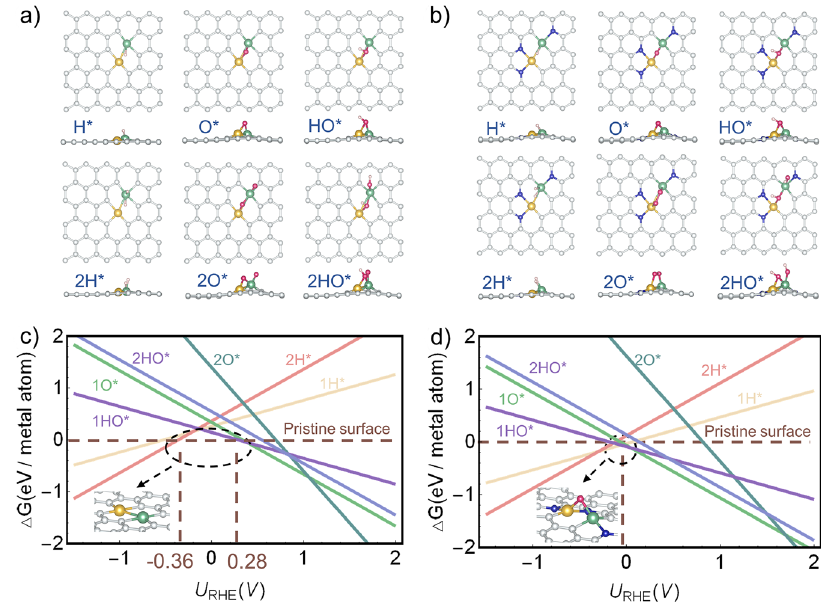
Fig. 3 Examples of the surface Pourbaix diagrams of DACs at pH = 0. a Adsorption con fi gurations of Fe-Ni-C and b Fe-Ni-N 1,2,4 -C, where yellow, green, blue, silvery, red, and light pink spheres represent Ni, Fe, N, C, O, and H, respectively. c Surface Pourbaix diagrams of Fe-Ni-C and d Fe-Ni-N 1,2,4 -C at pH = 0.